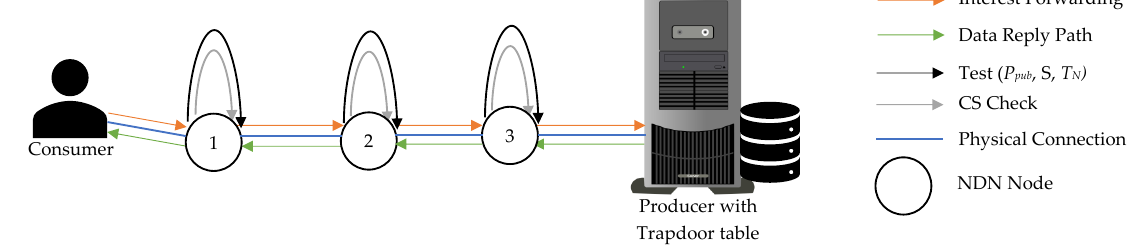
Figure 6. PEKS-based NDN